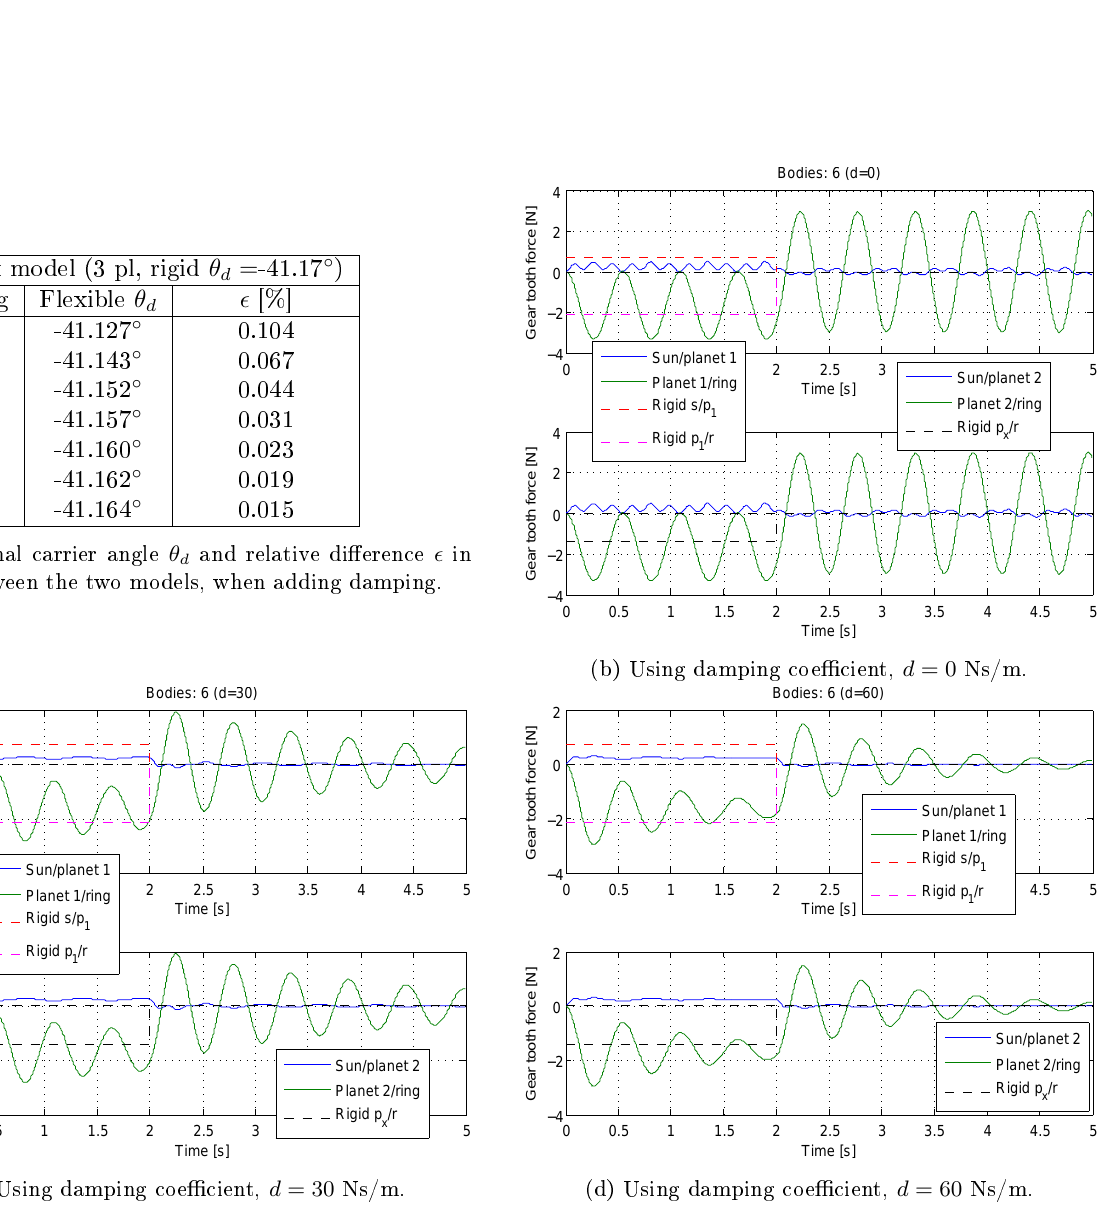
Figure 10: Gear tooth forces for the rigid vs. (cid:29)exibly-connected arti(cid:28)cial planetary multibody gearbox model for di(cid:27)erent damping